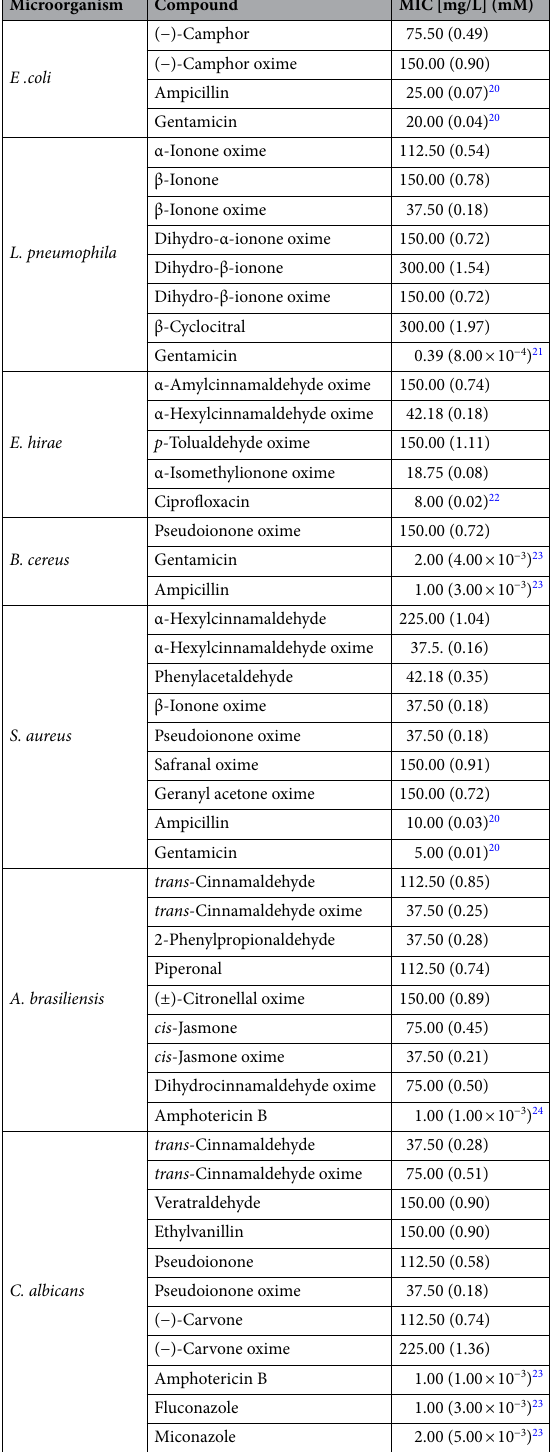
Table 3. The most relevant MIC